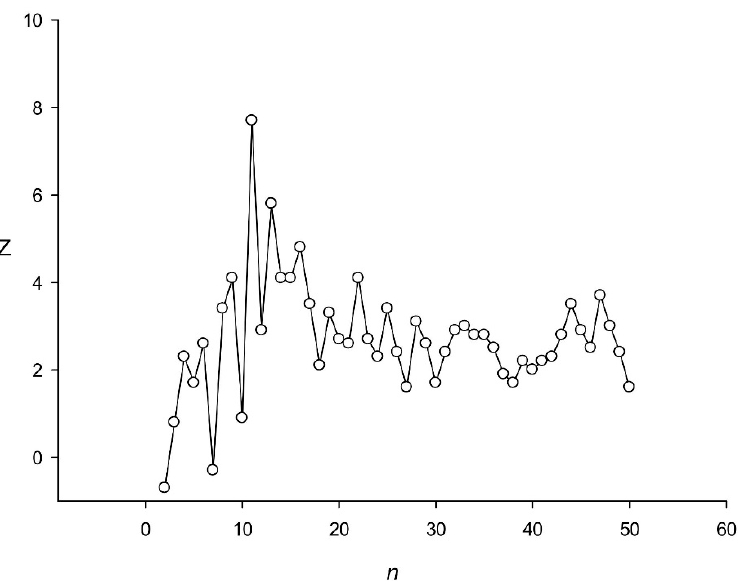
Figure 4. Dependence of Z ( n ) for the DNA region from 2,630,061 to 2,630,589 nt of the first rice chromosome. mF max (11) =